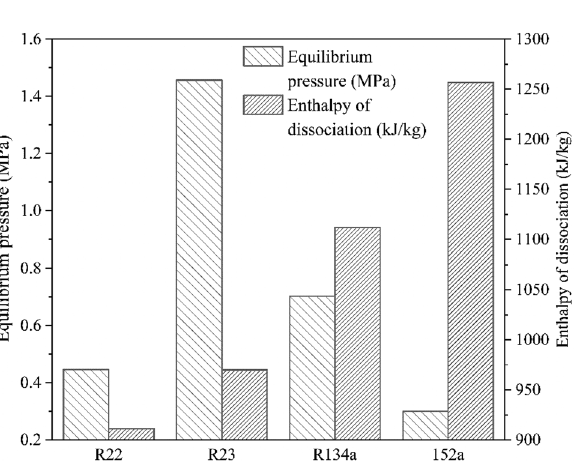
Figure 7. Model estimate of ( a ) enthalpy of dissociation as a function of operating temperature and compressibility of refrigerants, and ( b ) change in hydrate, liquid and vapor phase equilibrium pressure per unit change in the operating temperature in 3.5 wt.% NaCl solution. In figure ( b ), the solid legends depict the temperature range while the hollow legends indicate the compressibility range.